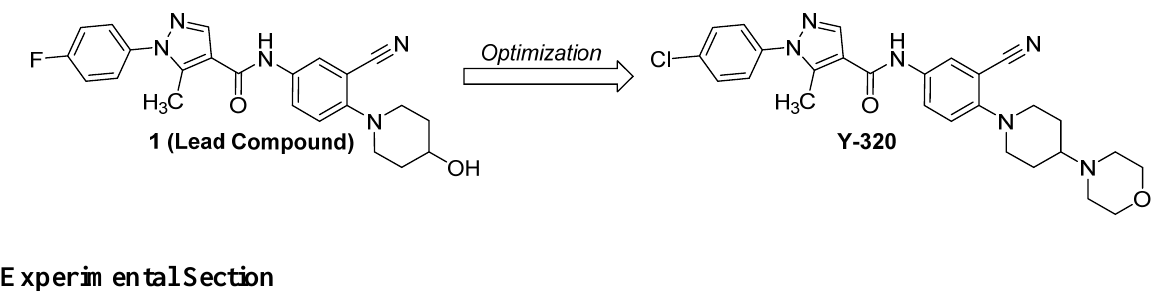
Figure 1. The structures of the lead compound 1 and